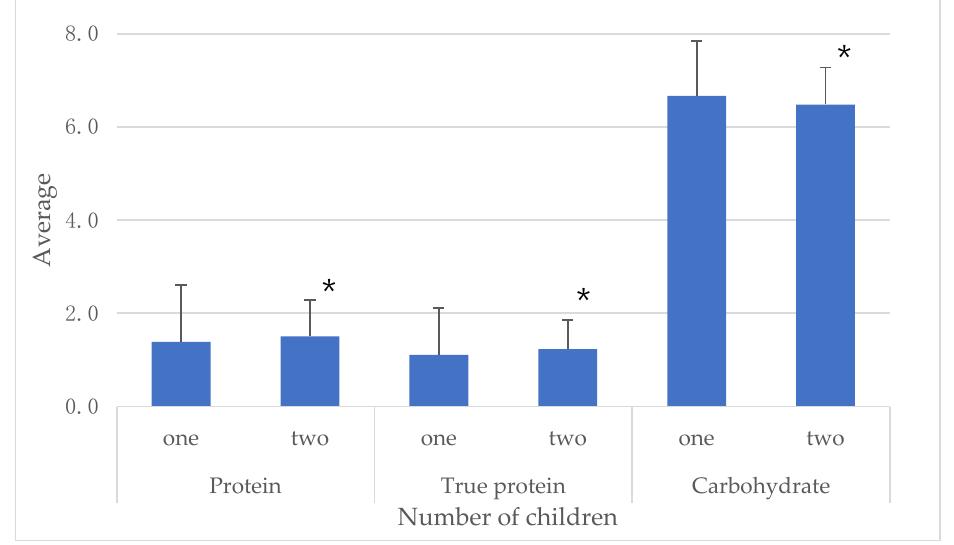
Figure 3. Concentrations of total protein, true protein and carbohydrates in the group of women with one or two children. * p < 0.05.